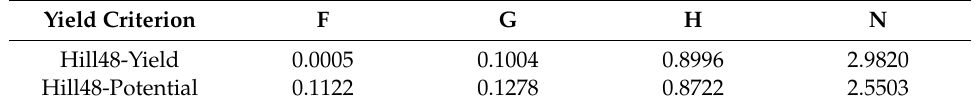
Table 12. Hill’s 48 coe ffi cients for